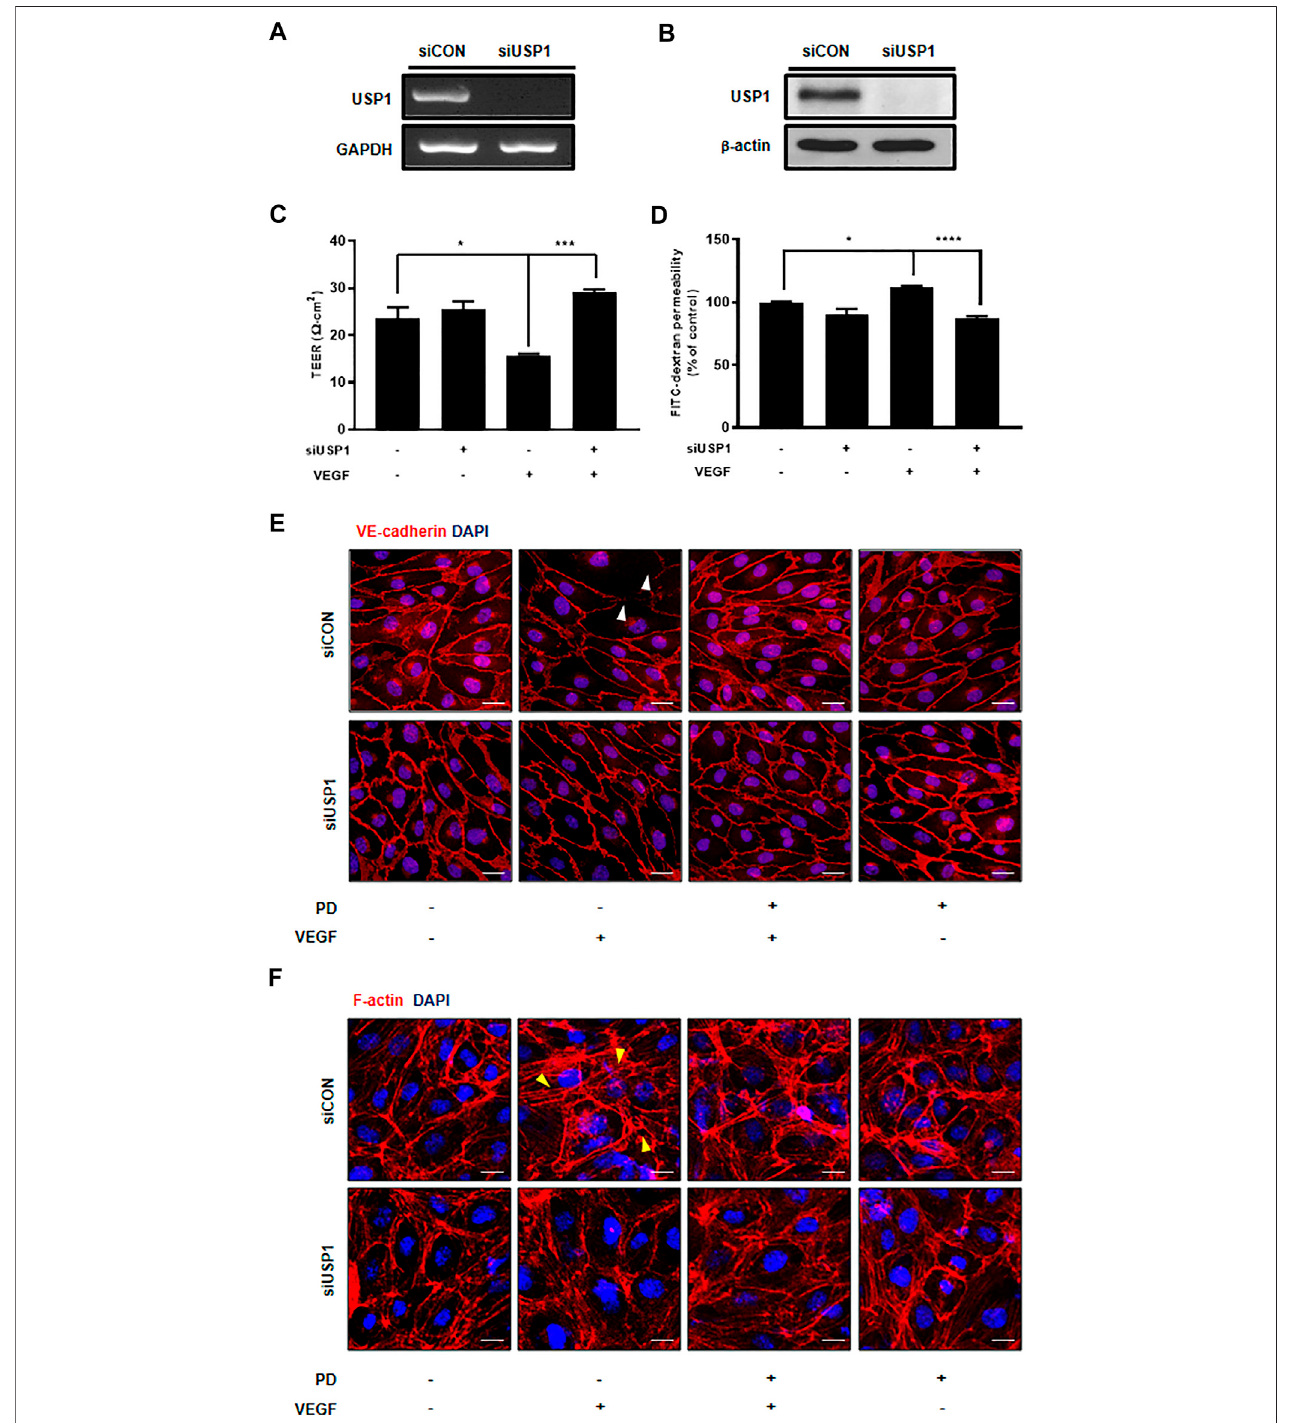
FIGURE 5 | USP1 knockdown inhibits VEGF-induced endothelial permeability and stabilizes junctional proteins. (A) Expression of USP1 mRNA by RT-PCR followingtransfectionwithUSP1siRNA. (B) WesternblotanalysisshowsUSP1expressionincellstransfectedwithUSP1-siRNA.TreatmentwithbothVEGFandsiUSP1 resulted in decreased endothelial permeability of TEER (C) and 70 kDa dextran (D) as compared with that obtained with VEGF treatment alone in HUVECs. n ≥ 3 independent experiments. siUSP1 cells were fi xed, permeabilized, and subsequently immunostained for VE-cadherin (E) and F-actin (F) . All data are presented as means ± SEM. * p < 0.05, *** p < 0.0005, **** p < 0.0001. Scale bar (cid:2) 20 μ M.